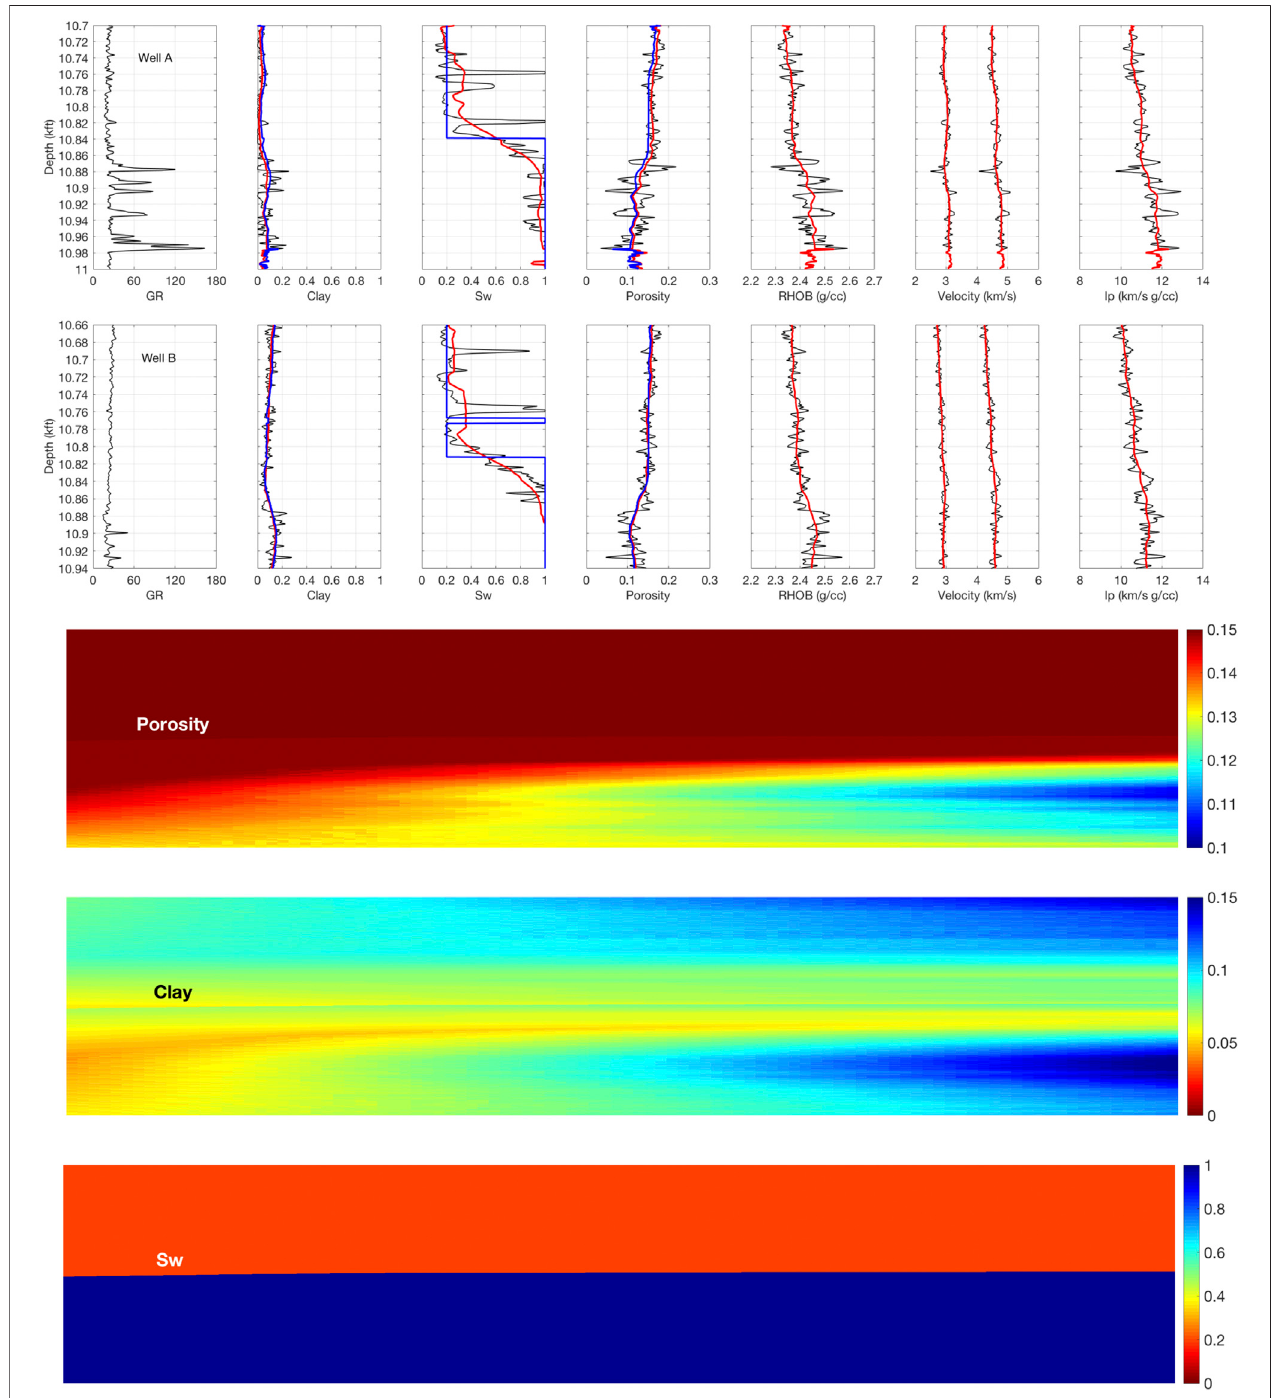
FIGURE 10 | Top: Interpretation results at the seismic scale (blue) for Well A and B. The upscaled variables are shown in red, while the wireline-scale variables are shown inblack. Bottom: Interpretedporosity (top) ,clay content (middle) ,and water saturation (bottom) sections betweenWell B (left) and A (right) .The inputs used were the interpolated upscaled I p and I s